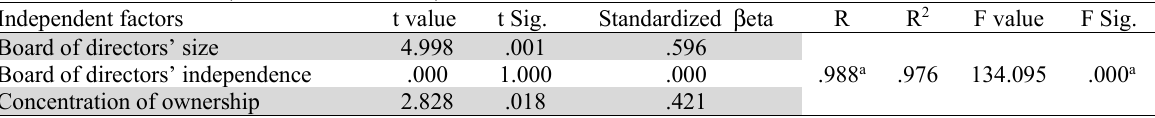
Results of multiple regression to test the impact of applying the principles of institutional governance (board of directors’ size, board of directors’ independence, concentration of ownership) on the accounting disclosure of service companies in Jordan with the indicator (return on assets ROA) Independent factors value t Sig. t